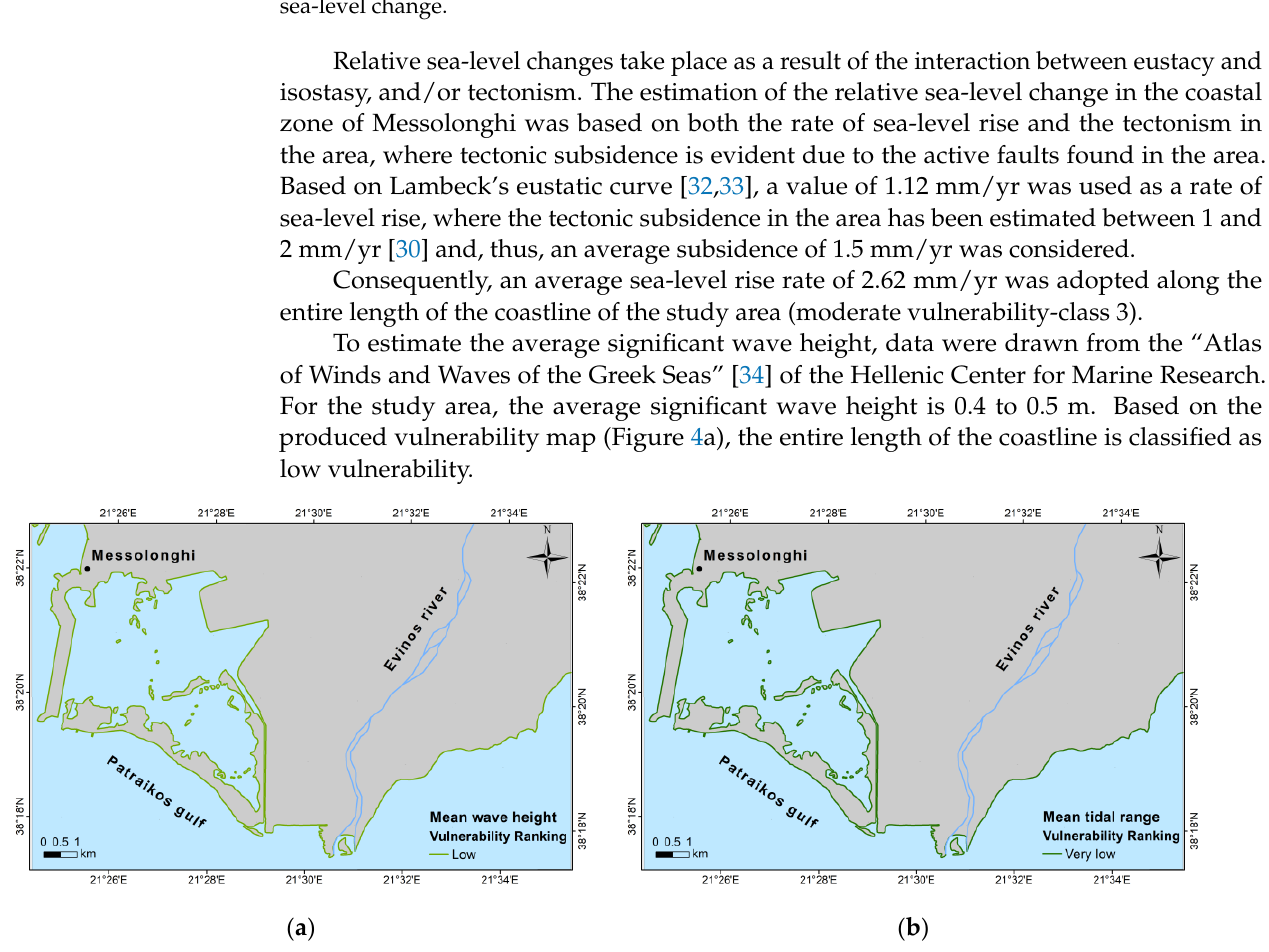
Figure 4. Assigned vulnerability classes in response to ( a ) mean wave height and ( b ) mean tidal